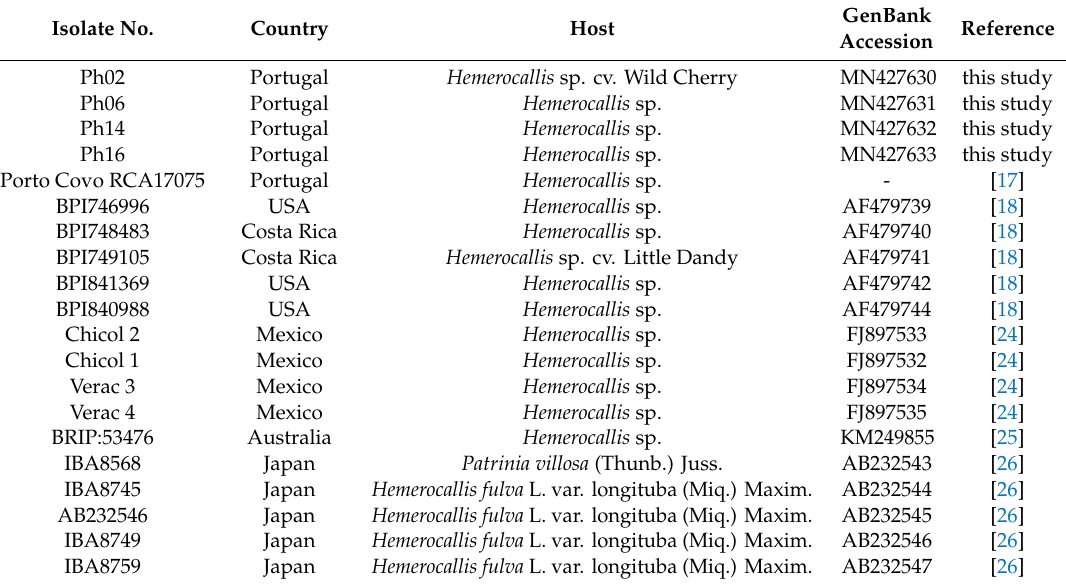
Table 8. Host, isolate number, country and GenBank accession of Puccinia hemerocallidis included in the phylogenetic